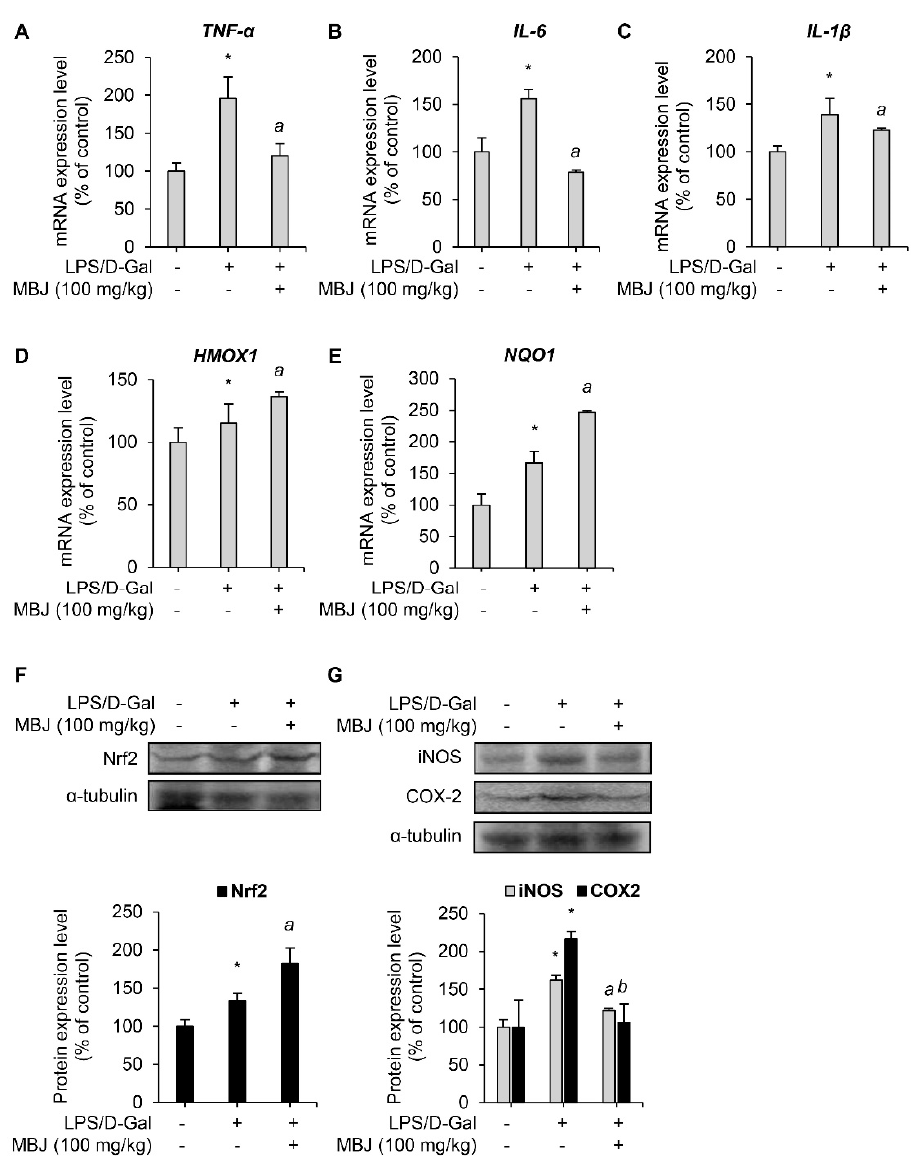
Figure 5. Antioxidant and anti-inflammatory effects of MBJ in vivo. ( A–E ) The mRNA expression levels of target genes in the spleen of mice were analyzed via RT-qPCR. The relative mRNA expression levels of inflammatory mediators ( TNF- α , IL-6 , and IL-1 β ) or antioxidant mediators ( HMOX1 and NQO1 ) are presented as a bar graph. The data are shown as the mean ± SEM; * p < 0.05 vs. the LPS/D-Gal-untreated group; a p < 0.05 vs. the LPS/D-Gal-treated and MBJ-untreated group. Mice spleen expression levels of ( F ) the Nrf2 protein and ( G ) the iNOS and COX-2 proteins were analyzed by immunoblotting. All protein levels were quantified using the LabWorks software and were normalized to the corresponding α -tubulin levels. The data represent the mean ± SEM; * p < 0.05 vs. the LPS/D-Gal-untreated group; a p < 0.05 and b p < 0.01 vs. the LPS/D-Gal-treated and MBJ-untreated groups.